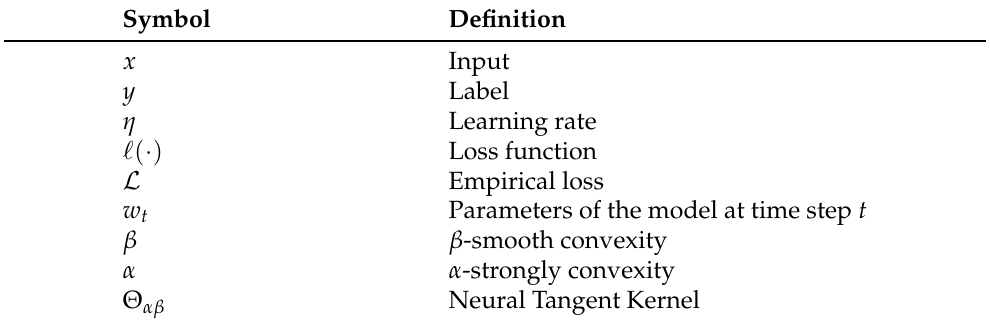
Table 1. Key symbols and their